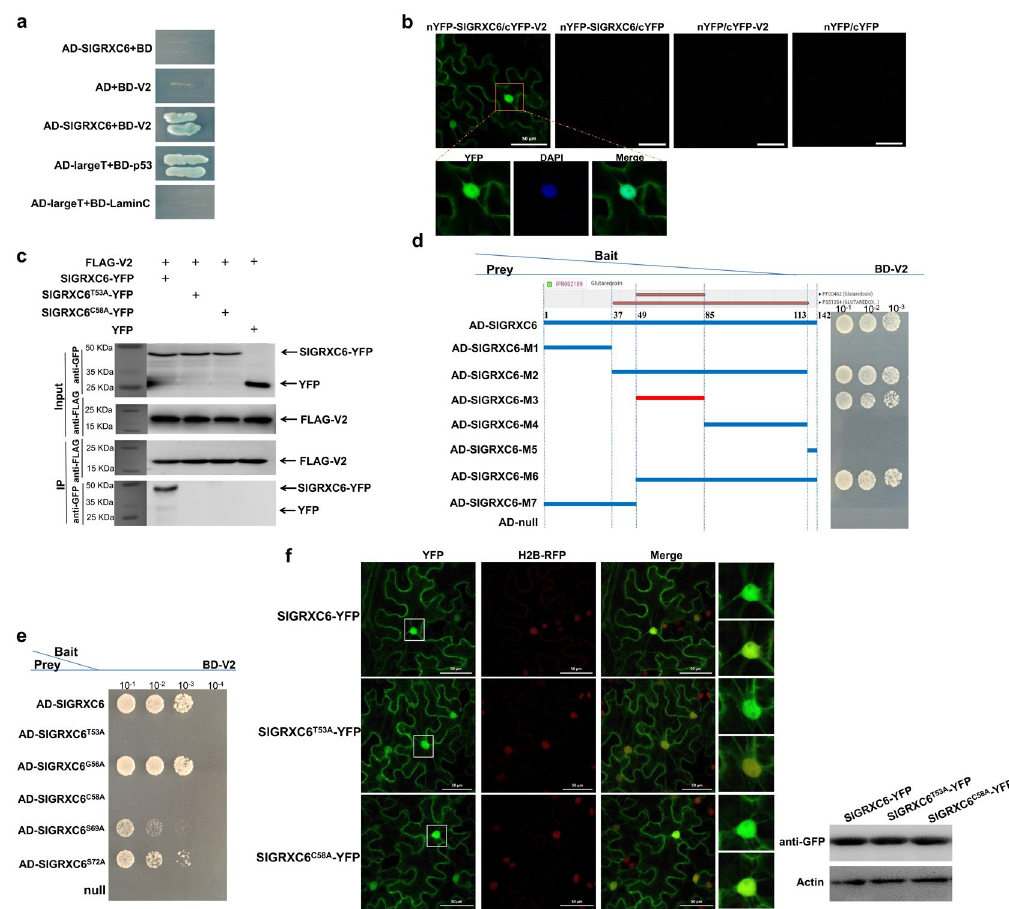
Fig 1. Identification of the interaction between V2 and SlGRXC6 proteins. (a) Y2H confirmed the interaction between V2 and SlGRXC6. SlGRXC6 was fused with a GAL4 activation domain (AD-SlGRXC6) and V2 was fused to a GAL4-binding domain (BD-V2), respectively. Yeast cells expressing the indicated protein pairs were plated onto the selection medium (SD/- His/-Leu/-Trp/-Ade) with X- α -Gal to screen for positive interactions. Yeast cells coexpressing pGADT7-largeT (AD-largeT) and pGBKT7-p53 (BD-p53) or AD-largeT and pGBKT7-LaminC (BD-LaminC) served as a positive and negative control, respectively. (b) The V2-SlGRXC6 interaction was confirmed by using a BiFC assay in N . benthamiana cells. The V2-SlGRXC6 interaction led to a reconstituted fluorescence signal. DAPI stains DNA in the nucleus. Bars: 50 μ m. Experiments were repeated three times and 30 cells were observed in each repeat. (c) A co-IP assay to test the interaction between V2 and SlGRXC6, SlGRXC6 T53A or SlGRXC6 C58A . N . benthamiana leaves were co-infiltrated with FLAG-V2 and SlGRXC6-YFP (Lane 1), FLAG-V2 and SlGRXC6 T53A -YFP (Lane 2), FLAG-V2 and SlGRXC6 C58A -YFP (Lane 3), or FLAG-V2 and YFP (Lane 4). Cell lysates were incubated with FLAG-Trap beads and proteins pulled down with beads were tested using the indicated antibodies. Samples before (Input) and after (IP) immunoprecipitation were analyzed by using anti-GFP or -FLAG antibody. (d) Schematic representation of the truncated mutants of SlGRXC6 and their interactions with V2 as analyzed using Y2H. (e) Interactions between the V2 and the SlGRXC6 mutants SlGRXC6 T53A , SlGRXC6 G56A , SlGRXC6 C58A , SlGRXC6 S69A , SlGRXC6 S72A using Y2H. (f) Subcellular localization of SlGRXC6-YFP, SlGRXC6 T53A -YFP or SlGRXC6 C58A - YFP in H2B transgenic N . benthamiana . The H2B-RFP signal represents the nucleus. Bars: 50 μ m. Experiments were repeated three times with similar results. A bimolecular fluorescence complementation (BiFC) assay was performed to verify the interaction between V2 and SlGRXC6 in plant cells. SlGRXC6 and V2 were fused to the N-ter- minal and C-terminal fragments of yellow fluorescent protein (YFP), respectively. The corre- sponding constructs were co-delivered into N . benthamiana leaves by agroinfiltration and fluorescence was observed using a confocal microscope at 48 hours post-agroinfiltration (hpai). A positive interaction between nYFP-SlGRXC6 and cYFP-V2 was observed in both the